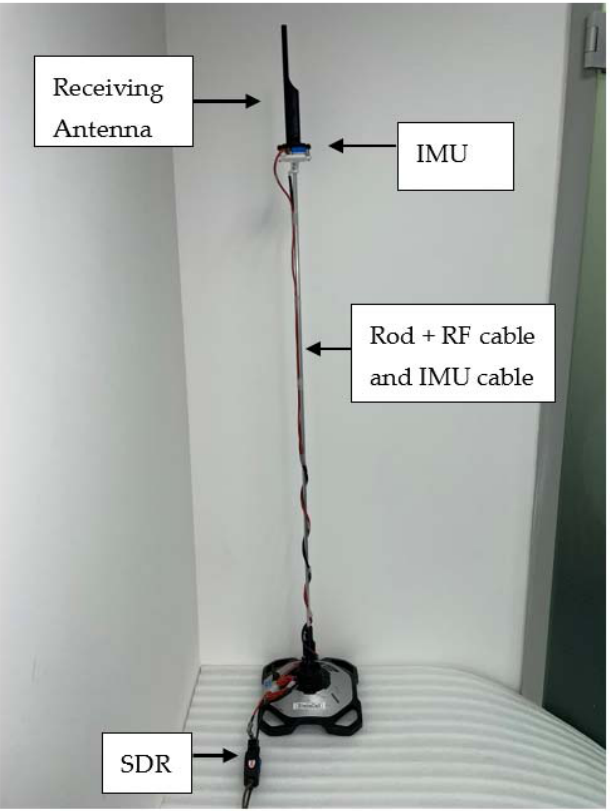
Figure 6. Receiving configuration including moving rod, receiving antenna, IMU, and SDR.